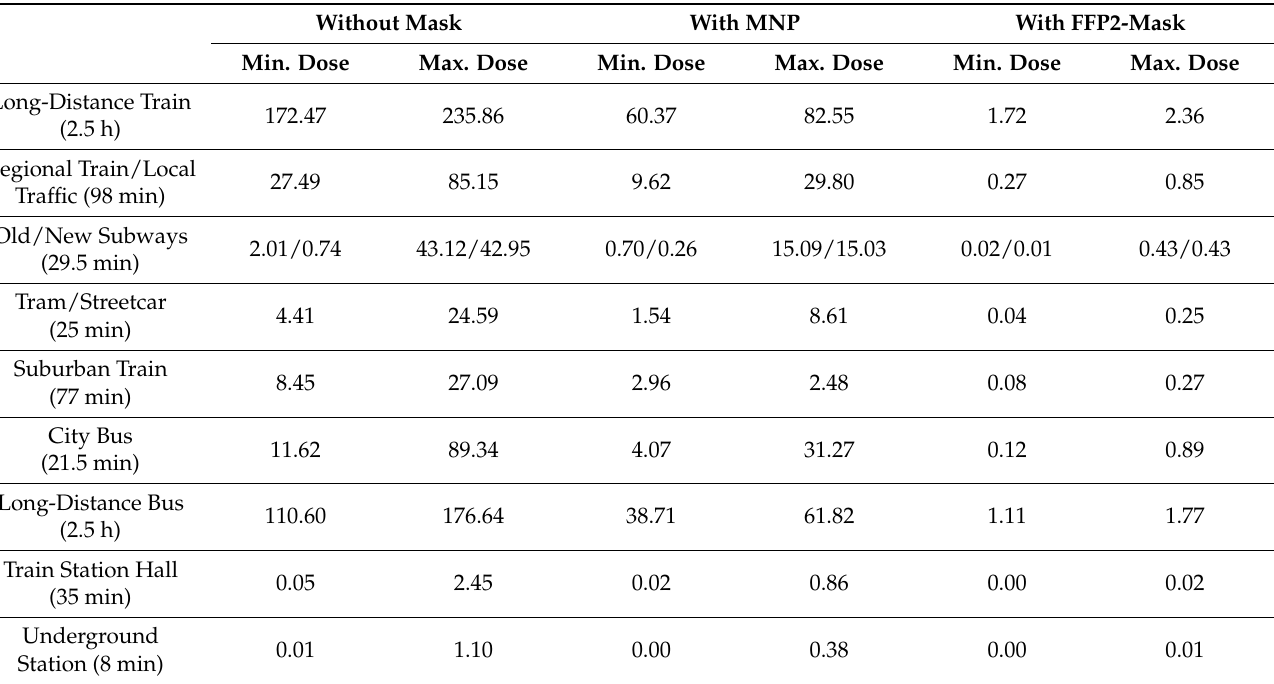
Table 6. Absorbed dose in mili-quanta when speaking loudly at close proximity (max. dose) or farther away from the emitter (min. dose) for the assumed durations of stay. With MNP With